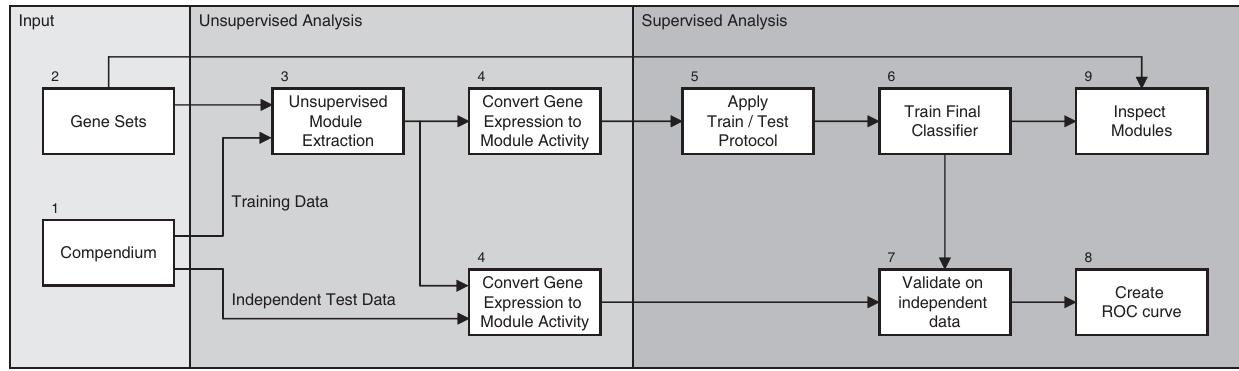
Figure 1. Workflow of the approach. We extended the analysis of compendia [10] to the supervised classification domain. Several microarray datasets were collected to construct compendia at various levels of underlying phenotype diversity (1). Additionally, we gathered a collection of biologically meaningful gene sets from available databases (2). Using the module extraction framework proposed by [10], we derived sets of modules (3) from these compendia and gene sets. Using these modules we construct a module activity matrix (4), allowing modules rather than single genes to be used as features. The predictive power of the different sets of modules is inspected within a classification context. Using a train/test protocol (5), we estimated the generalization error of all sets of modules [17]. Succeedingly, we trained a final classifier (6), which was then validated on independent data (7), and its performance assessed (8). Furthermore, the approach allows the final set of modules that were selected in the classifier to be compared to the original gene sets (9), allowing the identification of biological processes underlying the development and progression of cancer.